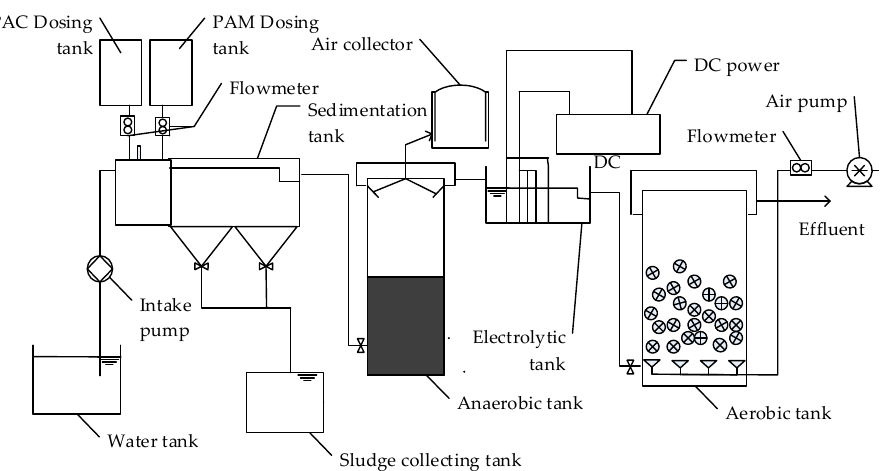
Figure 1. Experimental device for the treatment process.